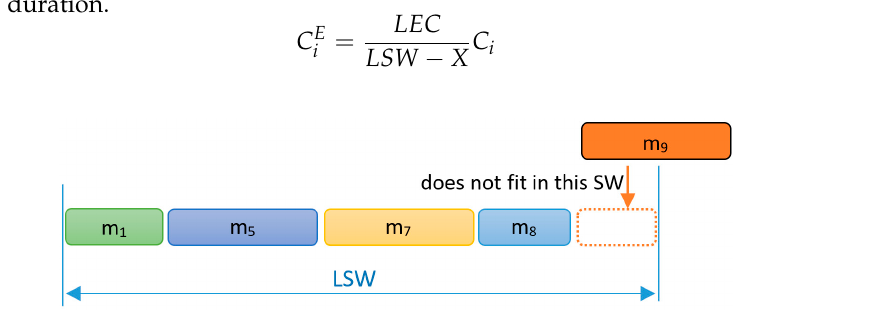
5 of 26 Figure 1 . Elementary Cycle (EC) and Trigger Message (TM) encoding in Flexible Time-Triggered - Controller Area Network (FTT-CAN). The Master uses an online scheduler that can implement any scheduling policy, e.g., FP (Fixed Priority), RM (Rate Monotonic), or EDF (Earliest Deadline First), being independent of the arbitration process of the underlying network technology. This node possesses a database, the System Requirements Database (SRDB), with the attributes of the messages and other system operational parameters, e.g., EC duration. The message set can be updated online using special control messages, e.g., to add and remove messages or modify their attributes. All such requests are directed to the Master node and subject to an admission control mechanism, being accepted only if they result in feasible system configurations. Event messages are triggered autonomously by the end-nodes, relying on the native CAN arbitration mechanism to prioritize and serialize concurrent transmissions. End-nodes are responsible for confining the event traffic to the AW. To do so, they use the information contained on the TM to determine the AW duration and suspend transmission at the appropriate times. A more in depth explanation of TT and ET traffic scheduling on FTT-CAN can be found in [20]. The FTT-CAN protocol has some critical points, which could hinder its utilization in systems where high levels of reliability and dependability are mandatory. For instance, the Master node is essential to the correct operation of an FTT-CAN network, constituting a single-point of failure. The work in [24] addresses the Master node replication to cope with permanent failures. Also, a solution to guarantee the TM delivery when this message is hit by errors or the Master suffers a transient fault is presented in [19]. To deal with bus permanent failures a bus replication scheme is proposed in [25], which could also increment the available bandwidth and/or increase system dependability. 3.2. Schedulability Tests in FTT-CAN and Real-Time Performance